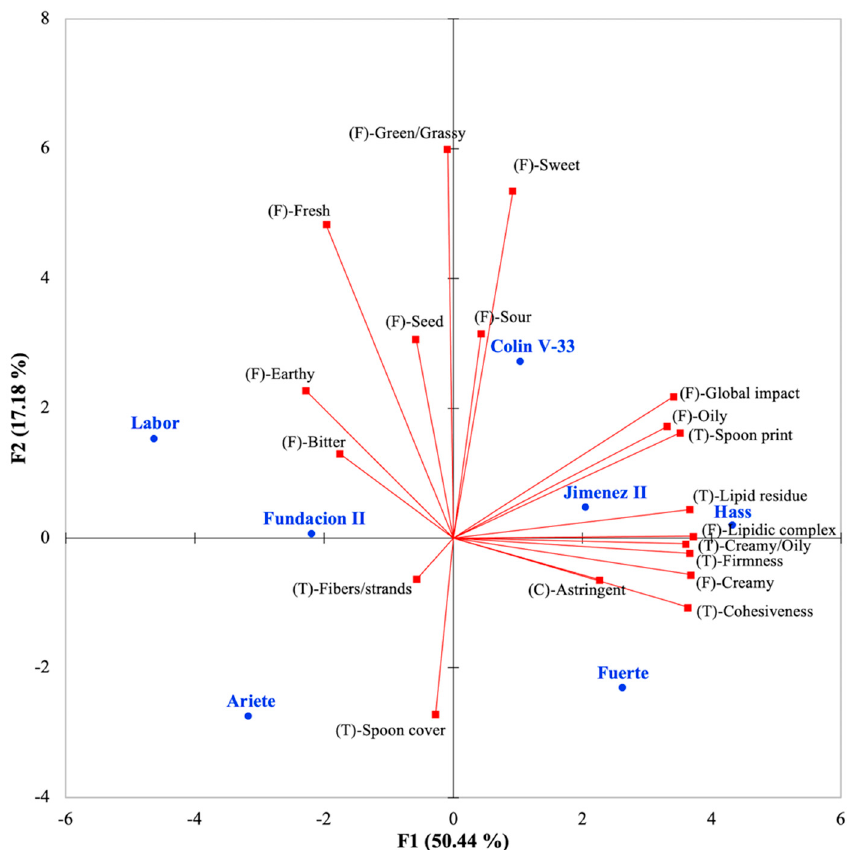
Figure 2. Principal component analysis (PCA) biplot of components F1 and F2, explaining 68% of the variance in the sensory descriptive profiles of seven avocado cultivars. Avocado samples are shown in blue ( • ), while vectors for sensory descriptive attributes are shown in red ( (cid:4) ), and the descriptor names are shown in black. Sensory attributes were also classified with an abbreviation that indicated if they were related to flavor (F), sensory texture (T), or a sensory chemical sensation factor (C).